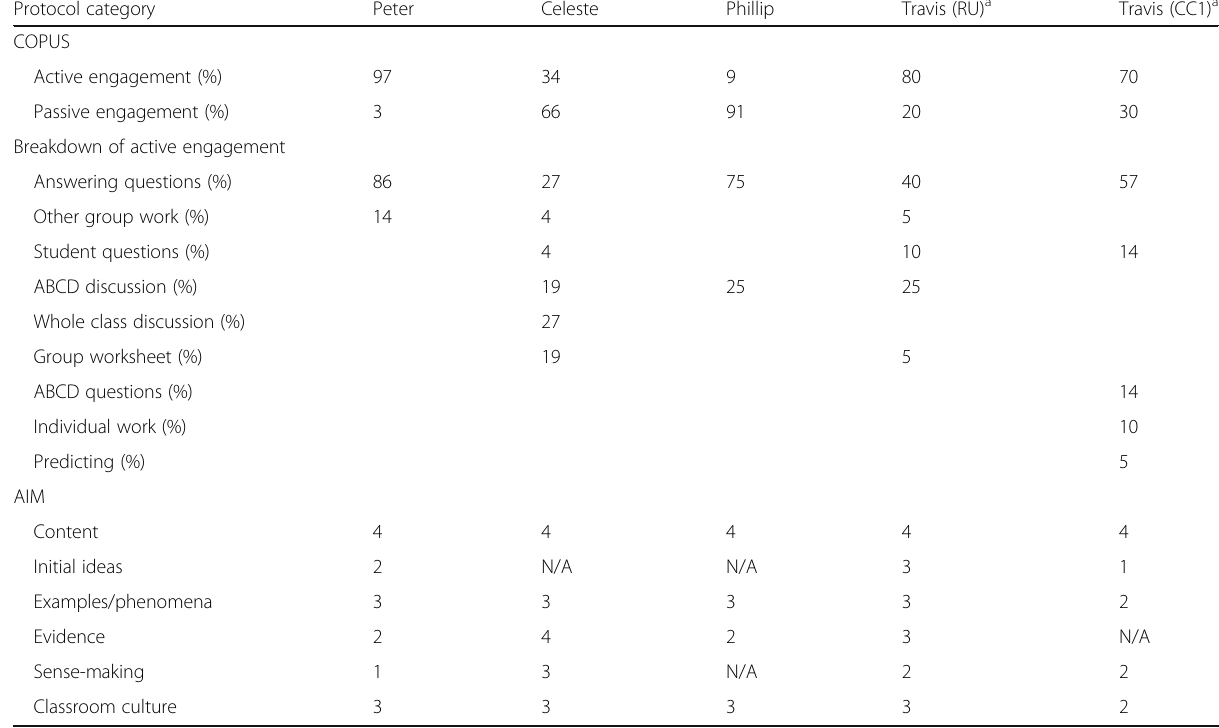
Table 4 COPUS and AIM protocol results for each case study subject Protocol